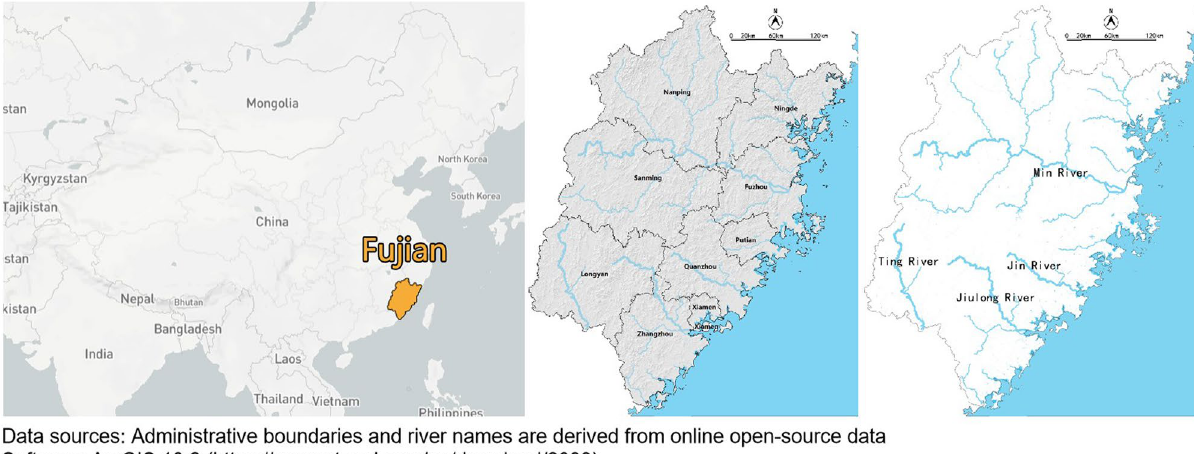
Figure 1. Location and map of Fujian Province,